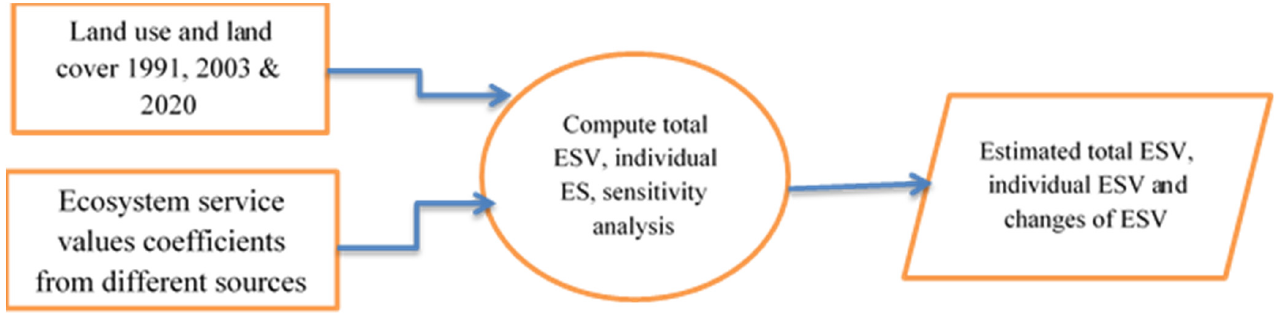
Figure 2. Framework for the assessment of the study ecosystem services in Matenchose watershed.